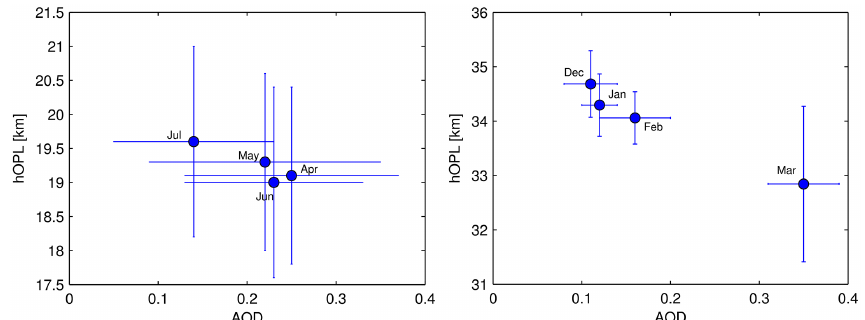
Figure 8. Monthly averaged hOPLs at Zugspitze and multi-year-averaged (2004–2009) monthly means of hOPLs at Pico Espejo as a function of spatially averaged aerosol optical depth (AOD) over selected regions (see Table 3). The standard deviation of daily and monthly means is given for Zugspitze and Pico Espejo (see Table 3). Here, hOPL is obtained from O 4 DSCDs as retrieved for the 346–372nm fitting window, and AOD measurements at 550nm from MODIS are